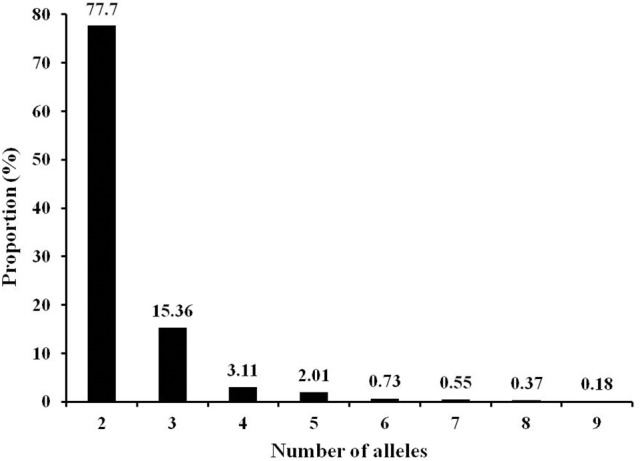
Frequency distribution of alleles in 192 tomato accessions generated by 547 InDel markers.